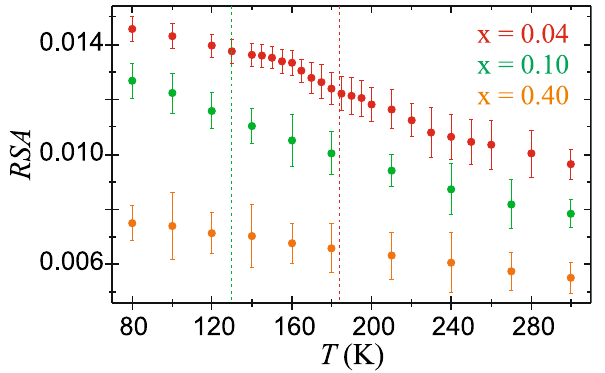
Figure 8. Temperature dependencies of the relative spectral area ( RSA ) for EuFe 2−x Ni x As 2 with x = 0.04, 0.10, 0.40. Vertical dashed lines at 184 K and 130 K denote the SDW order temperatures for x = 0.04 and x = 0.10, respectively. Each RSA set is derived from series of measurements performed at constant conditions (see text for details). Note: despite the identical weights of samples the sets of RSA differ due to difference in the resonant thickness ( 57 Fe content) between particular